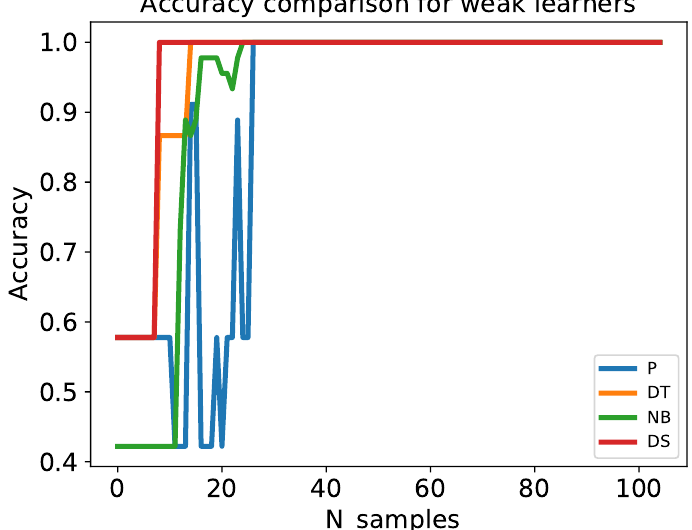
Figure 4. Comparison of weak learner accuracy.